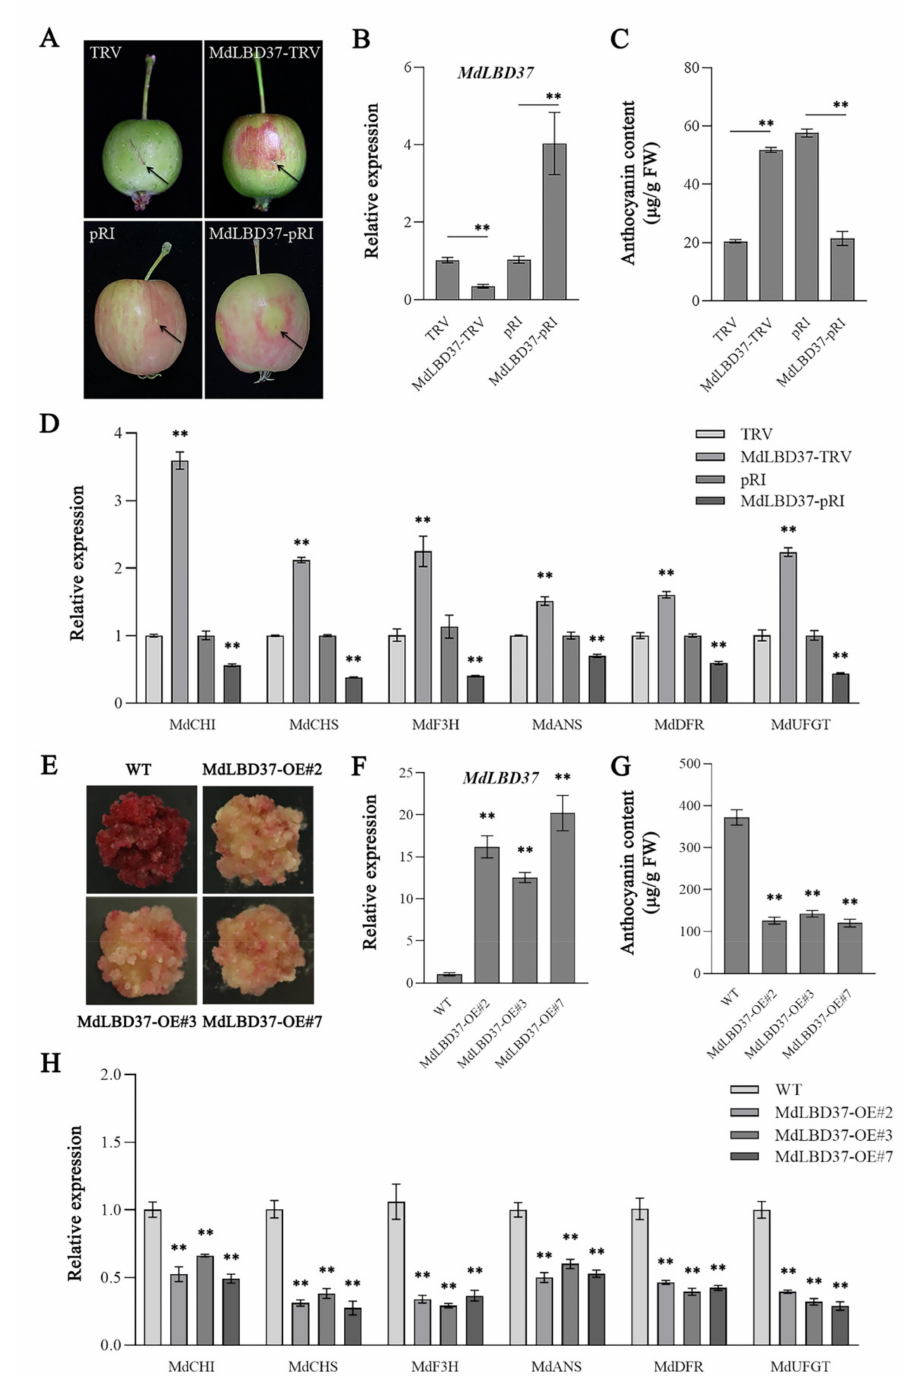
Figure 6. MdLBD37 -mediated inhibition of anthocyanin synthesis in apple. ( A ) The phenotypes of WT, MdLBD37 -TRV, and MdLBD37 -pRI apple fruit. ( B ) The expression levels of MdLBD37 in WT, MdLBD37 -TRV, and MdLBD37 -pRI apple fruit. ( C ) Anthocyanin contents in WT, MdLBD37 -TRV, and MdLBD37 -pRI apple fruit. FW, fresh weight. ( D ) The expression levels of anthocyanin-related genes in WT, MdLBD37 -TRV, and MdLBD37 -pRI apple fruit. ( E ) Phenotypes of MdLBD37 -overexpressing ( MdLBD37 -OE) apple calli. ( F ) The expression levels of MdLBD37 in WT and MdLBD37 -OE apple calli. ( G ) Anthocyanin contents in WT and MdLBD37 -OE apple calli. ( H ) The expression levels of anthocyanin-related genes in WT and MdLBD37 -OE apple calli. FW, fresh weight. Values suggest means ± SD of three independent biological replicates. Statistical significance was computed with the use of Student’s t -test (** p <